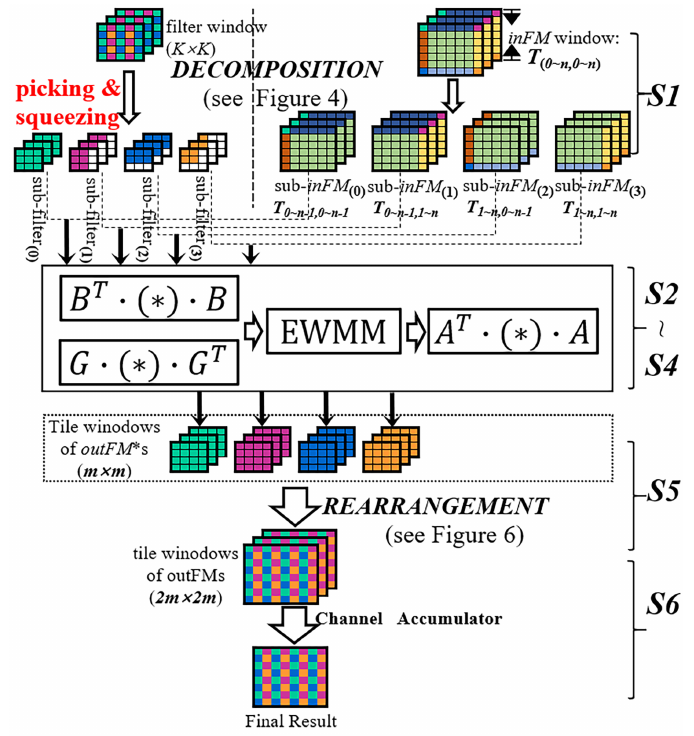
Figure 7. An algorithmic chart for the proposed Wino-transCONV